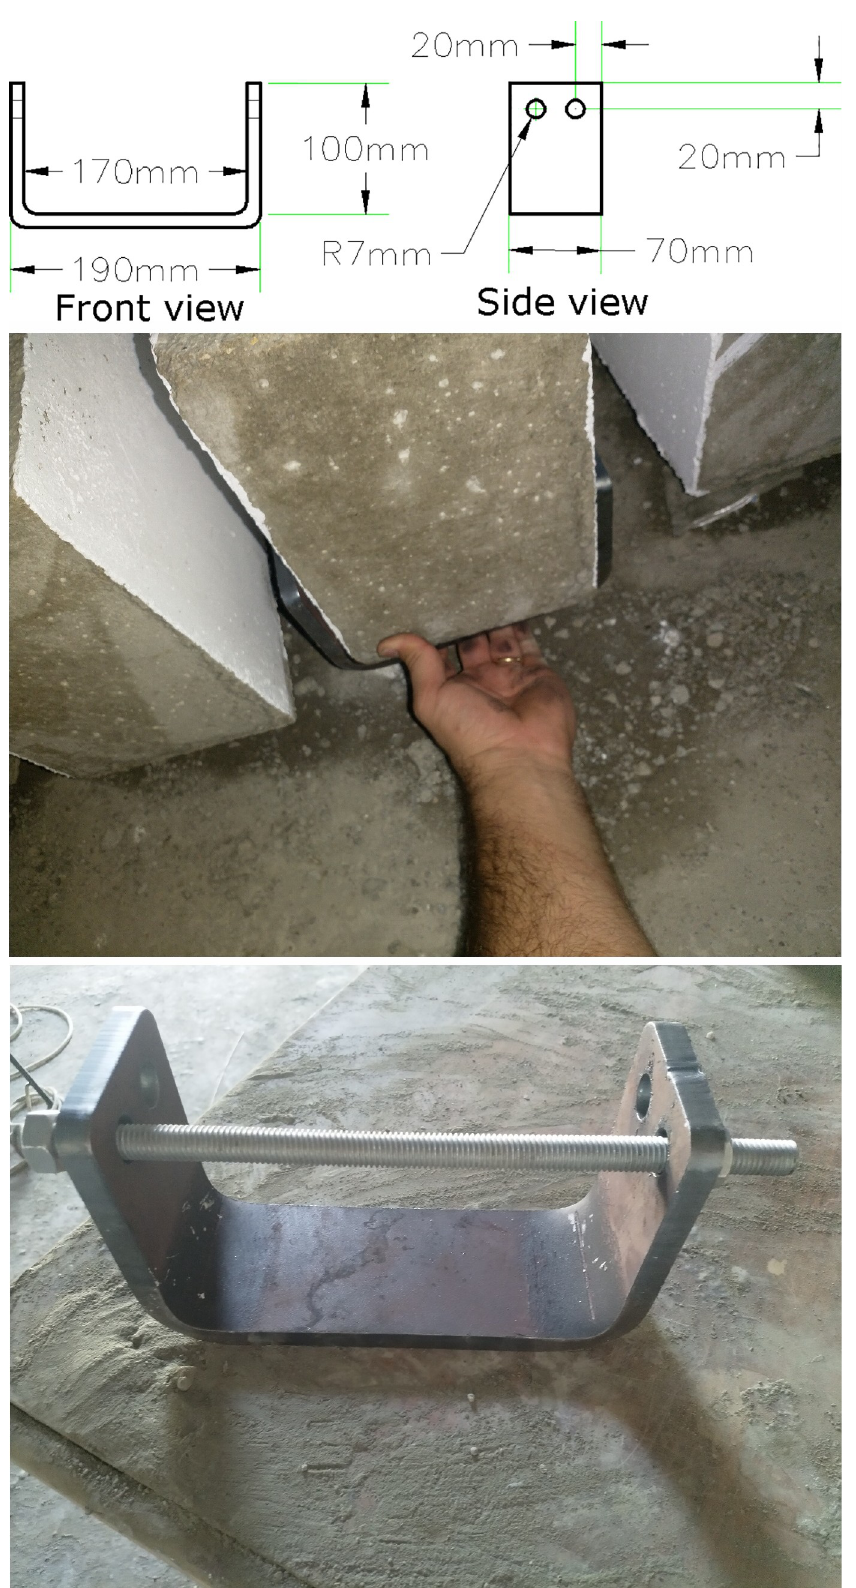
Fig 4. Steel channel details. (a) Front view and side view of the steel channel. (b) Steel channel in its location on the beam. (c) Steel channel with a full body stud bolt. https://doi.org/10.1371/journal.pone.0253816.g004 PLOS ONE | https://doi.org/10.1371/journal.pone.0253816 June 30,